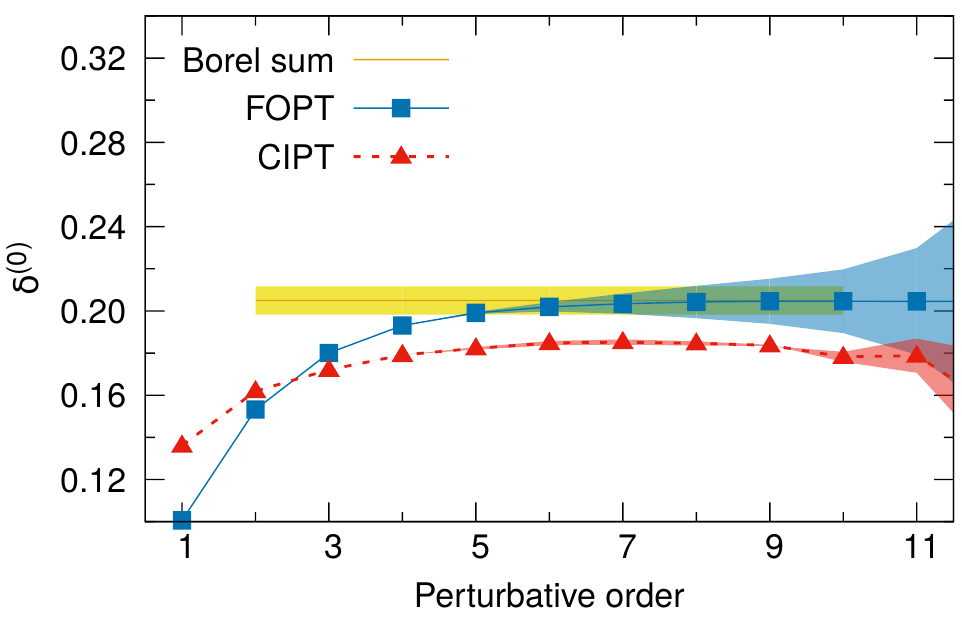
Figure 8. Final results for (cid:14) (0) in QCD using the coe(cid:14)cients of table 6 and the result of eq. (5.3). The bands in the perturbative expansions re(cid:13)ect the uncertainty in the coe(cid:14)cients while the band in the sum of the series is obtained from the spread of the values from individual PAs (last columns of tables 4 and 5). We use (cid:11) s ( m 2 ) = 0 : (cid:28)